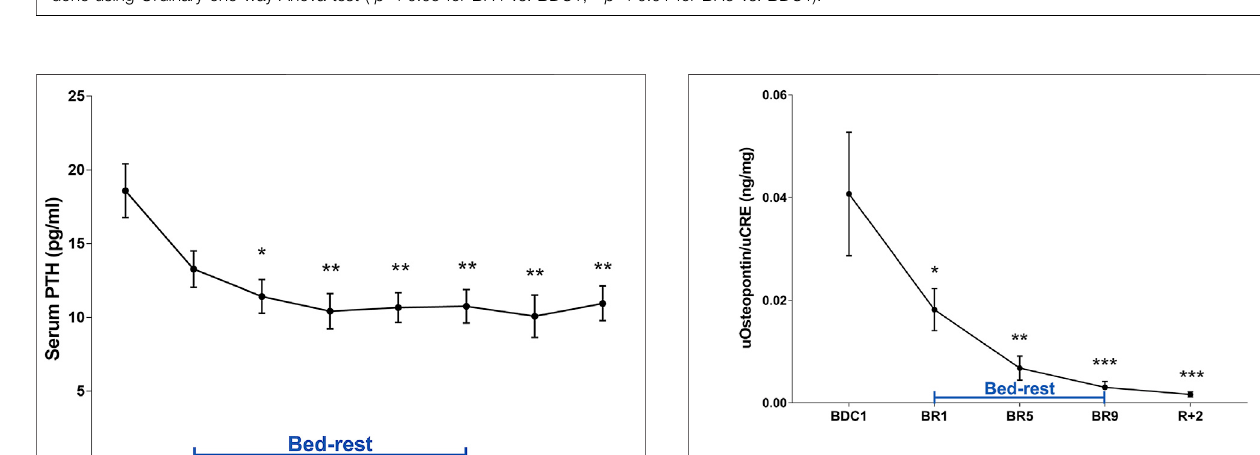
FIGURE 3 | Urinary Calcium excretion normalized to Creatinuria (mmol/mg) during 10-day bedrest. Data are expressed as mean ± S.E.M. Statistical analysis was done using Ordinary one-way Anova test (* p < 0.05 for BR4 vs. BDC1; ** p < 0.01 for BR5 vs. BDC1).